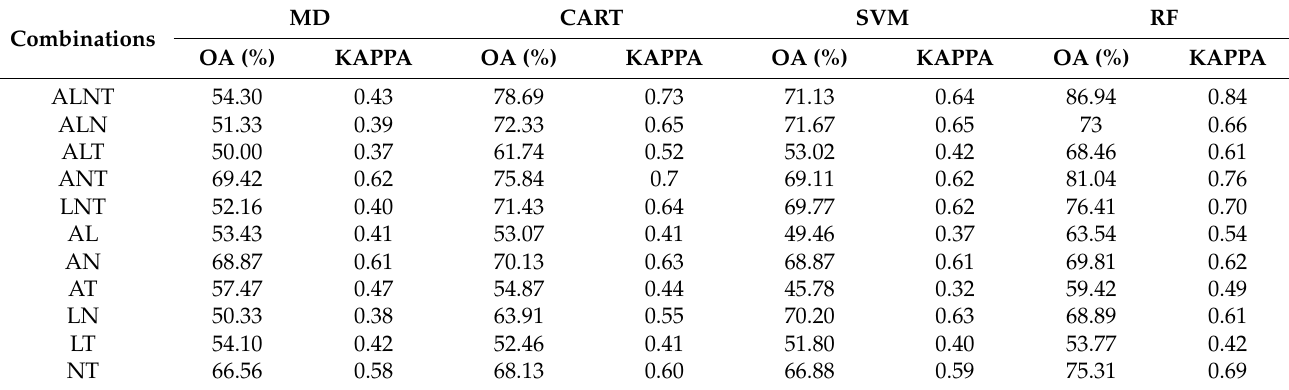
Table 3. Accuracy validation of four models with different combinations of